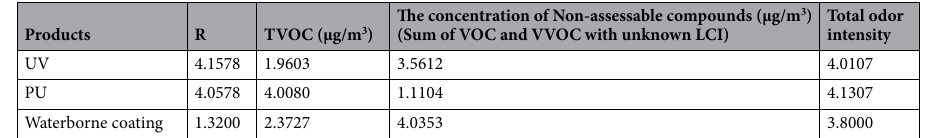
Table 3. Quality index of Choerospondias axillaris (Roxb.) Burtt et Hill with different lacquers.